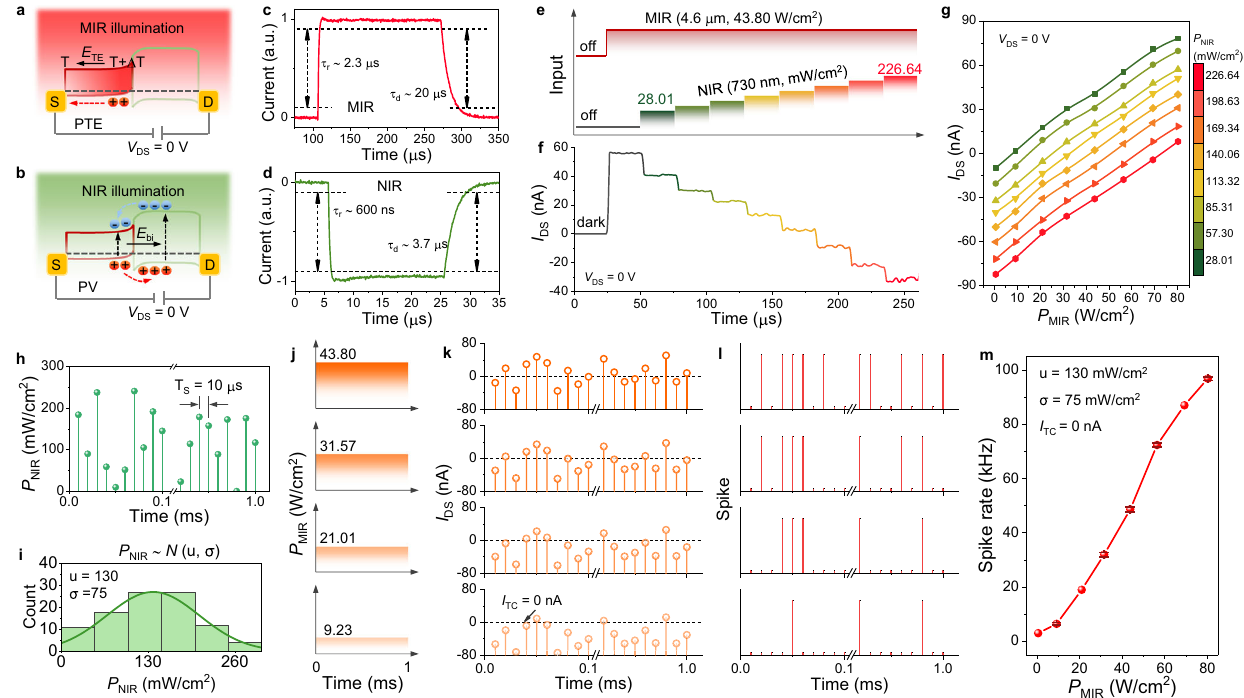
Fig. 2 | Perception and encoding characteristics of the 2D MIR optoelectronic retina.a , b Photoresponsemechanismsoftheb-AsP/MoTe 2 heterostructureunder MIR and NIR global illumination at V DS =0V. c , d Photoresponse rate of the het- erostructure at V DS =0V. The NIR (730nm) and MIR (4.6 μ m) photoresponse rate of the heterostructure are as fast as 600ns/3.7 μ s and 2.3 μ s/20 μ s, respectively. e , f Output photocurrents ( I DS ) of the heterostructure under an input of simulta- neousMIRandNIRilluminations.ThepowerdensitiesofMIRandNIRareshownin ( e ). g ThedependenceofoutputphotocurrentontheMIRpowerdensityunderthe modulation of NIR light with various power densities. h One train of NIR optical pulses (100 time-steps (pulses) for one train) that are randomly sampled from a